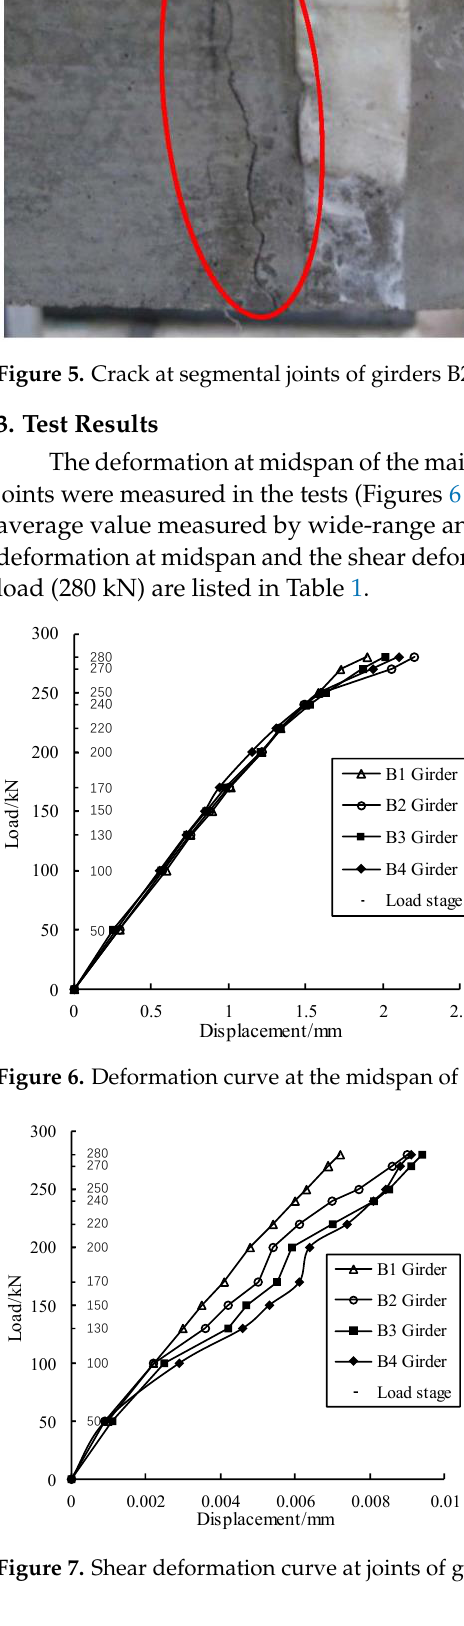
Figure 7. Shear deformation curve at joints of girder specimens.